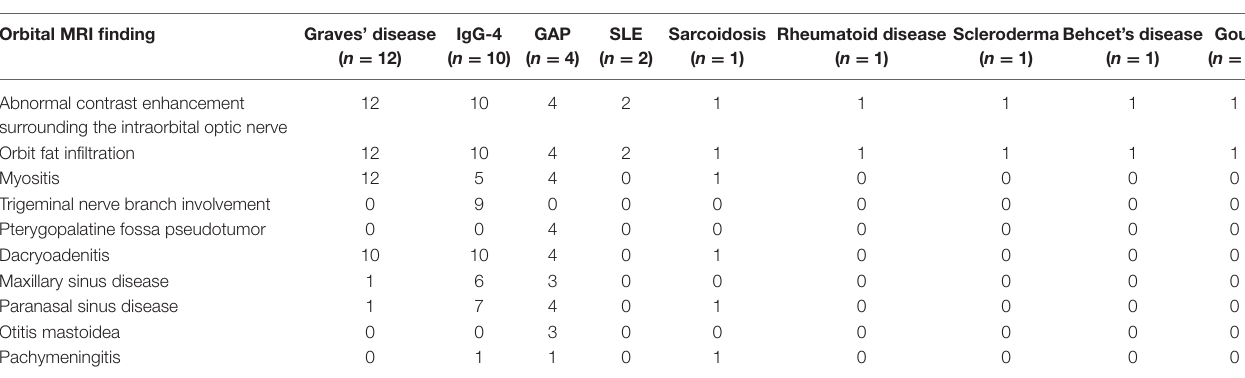
TABLE 4 | Orbital MRI findings of OPNs with CTD. Orbital MRI